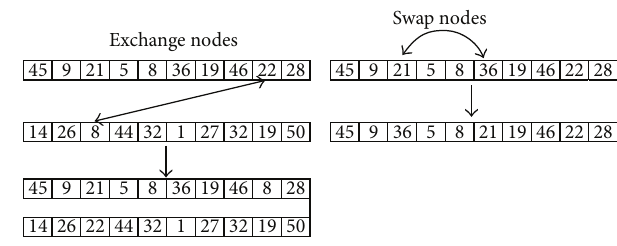
Figure 9: Several common mutation